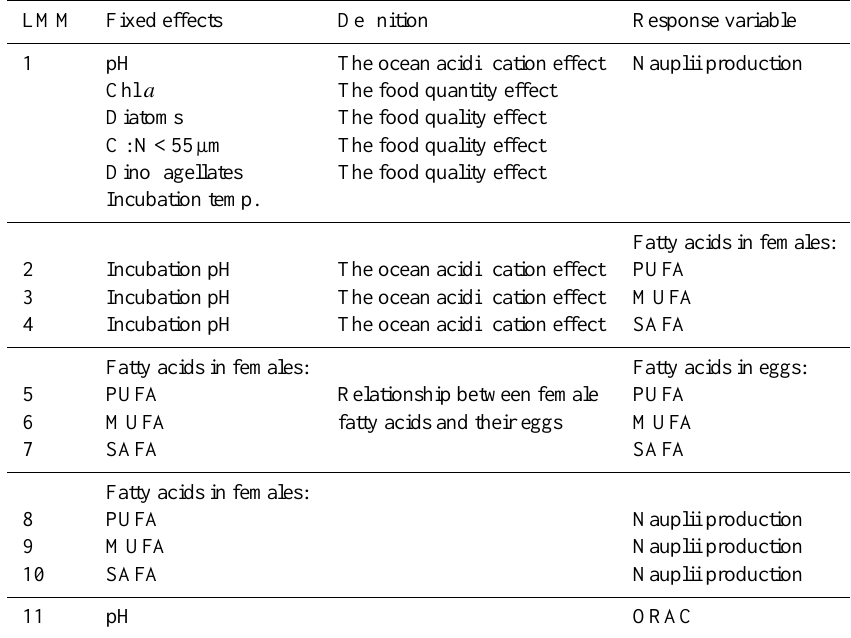
Table 2. Variables that were used in the full LMM models (numbers indicate separate models). Repeated measures were used as random effects in the models, as samples from the same enclosures are dependent on each